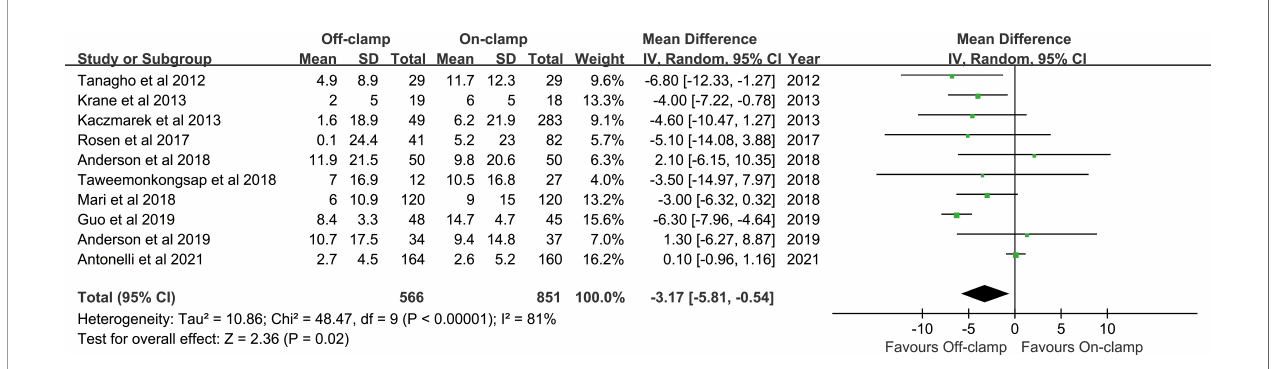
FIGURE 5 | Forest plots of renal functional outcome: long-term % decrease in